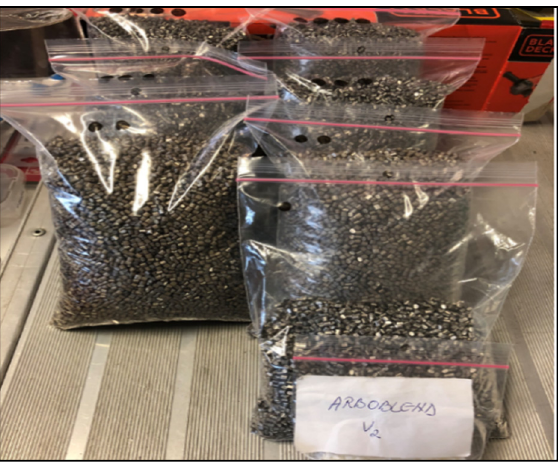
Figure 5. The first cycle of PVD coating of the Arboblend V2 Nature pellets with silver nanoparticles .